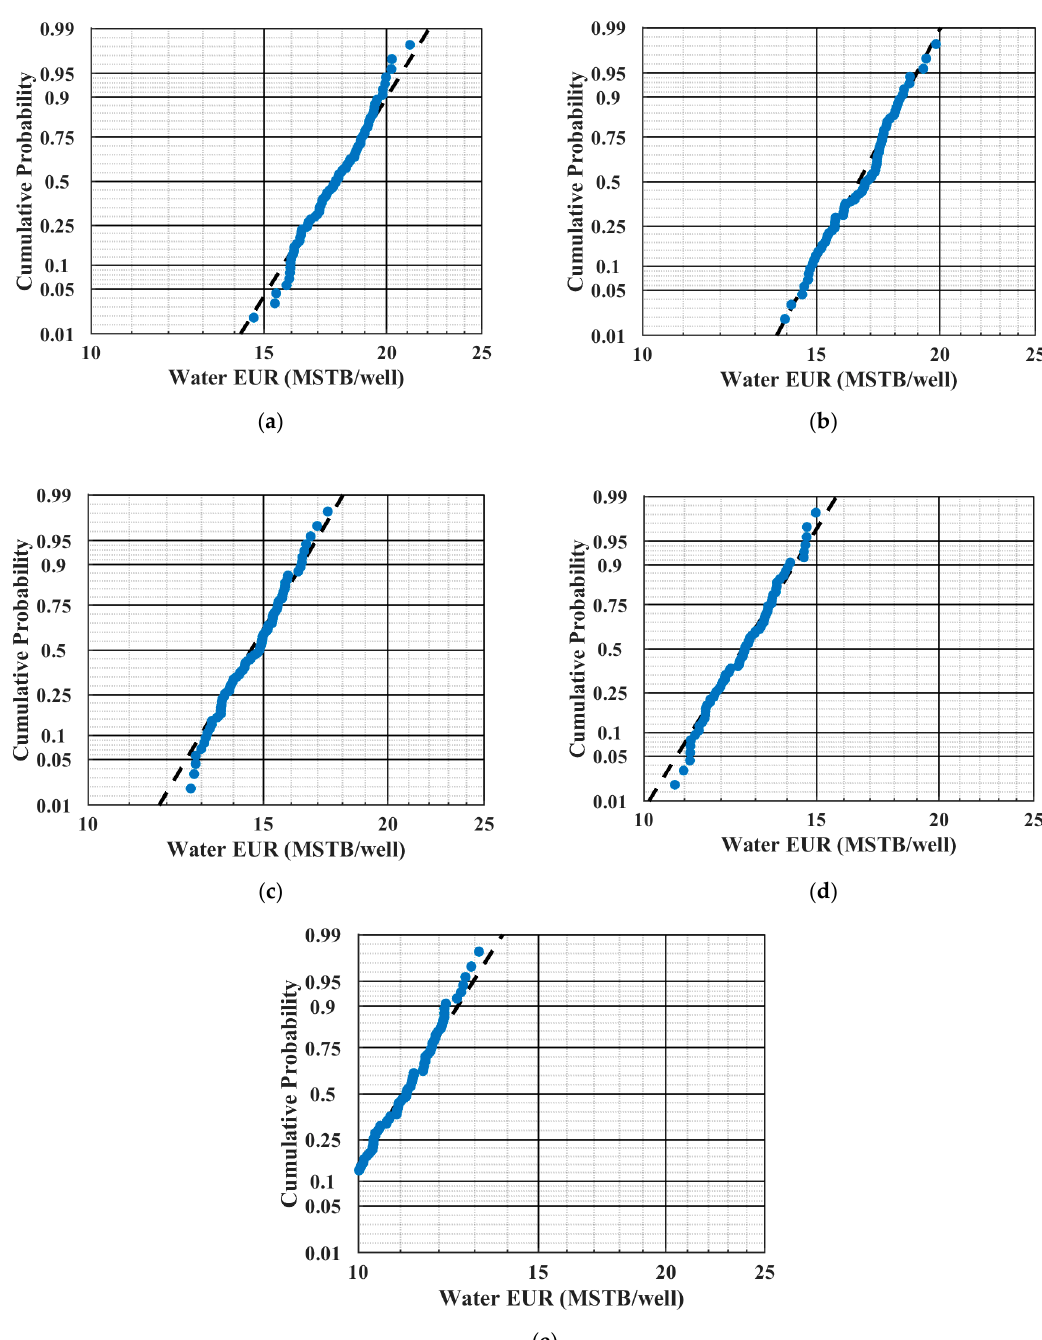
Figure 9. Estimated ultimate water recovery per well for the different well spacing scenarios (MSTB represents thousand stock tank barrel ): ( a ) the two-well spacing of 472 m (1550 ft); ( b ) the three-well spacing of 315 m (1033 ft); ( c ) the four-well spacing of 236 m (775 ft); ( d ) the five-well spacing of 189 m (620 ft); and ( e ) the six-well spacing of 158 m (517 ft). Table 3. Summary of the P10, P50, P90 values of gas and water for 20 years EUR for all five different spacing scenarios.